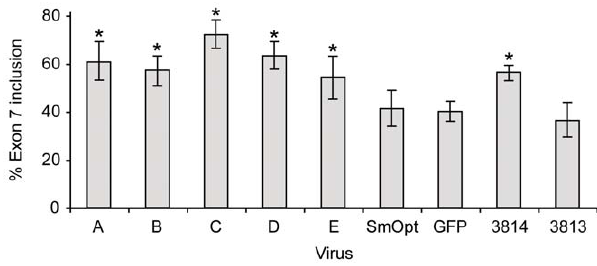
Figure 3. Evaluation of endogenous SMN splicing patterns in SMA type I patient-derived fibroblasts. SMA type I 3813 cells were transduced with Adv-5 vectors expressing antisense U7 snRNAs or control vectors (GFP, SmOpt) at a MOI of 20. Cells were passaged for 10 days in 2% FBS medium, and then harvested for RNA extraction. The bar graph gel image summarizes the levels observed from 8 independent experiments. Standard deviations are shown for each series. An asterisk above bars indicates a statistically significant difference between the experimental series and the SmOpt control series. A statistically significant difference between series is defined by p-values ,